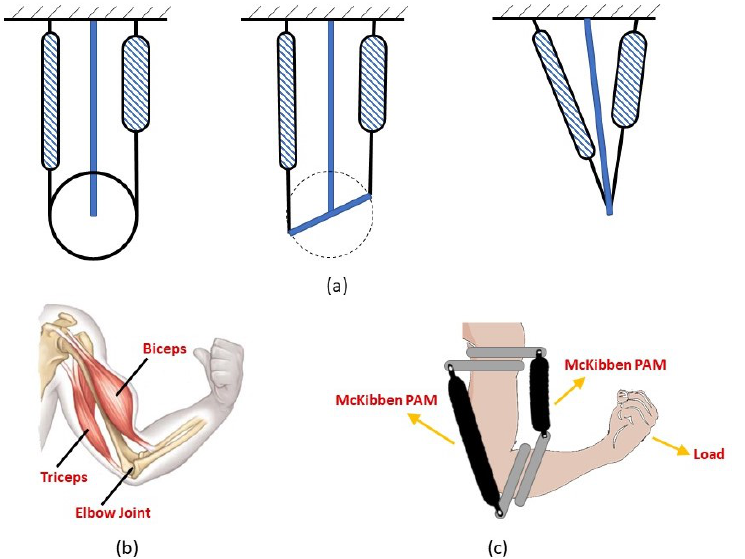
Figure 1. Schematic diagram of antagonistic structure: ( a ) three common antagonistic configurations; ( b ) biological antagonistic muscles; ( c ) manipulator design with antagonistic